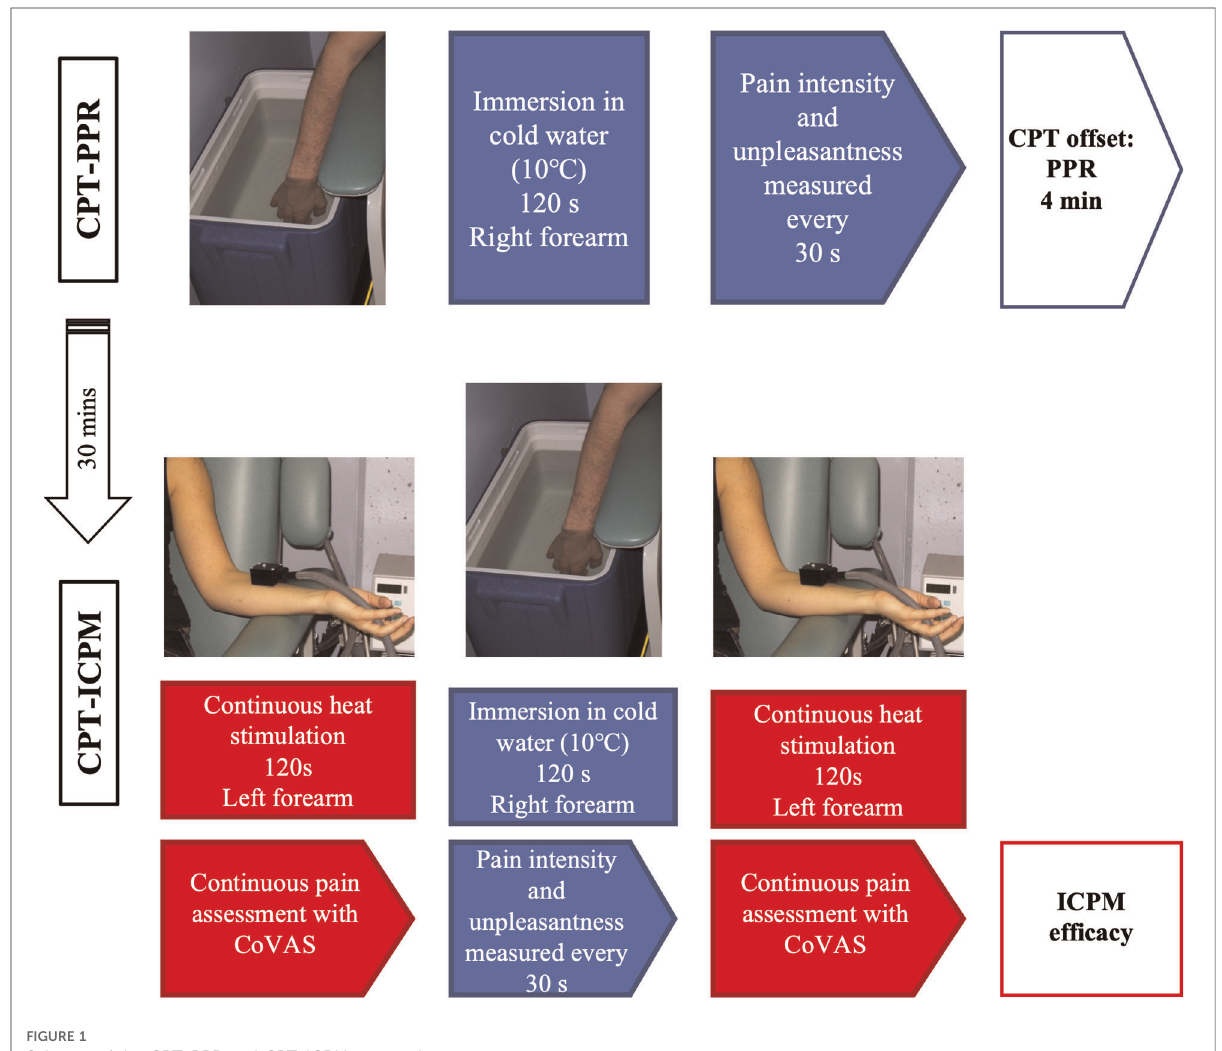
FIGURE 1 Schema of the CPT-PPR and CPT-ICPM